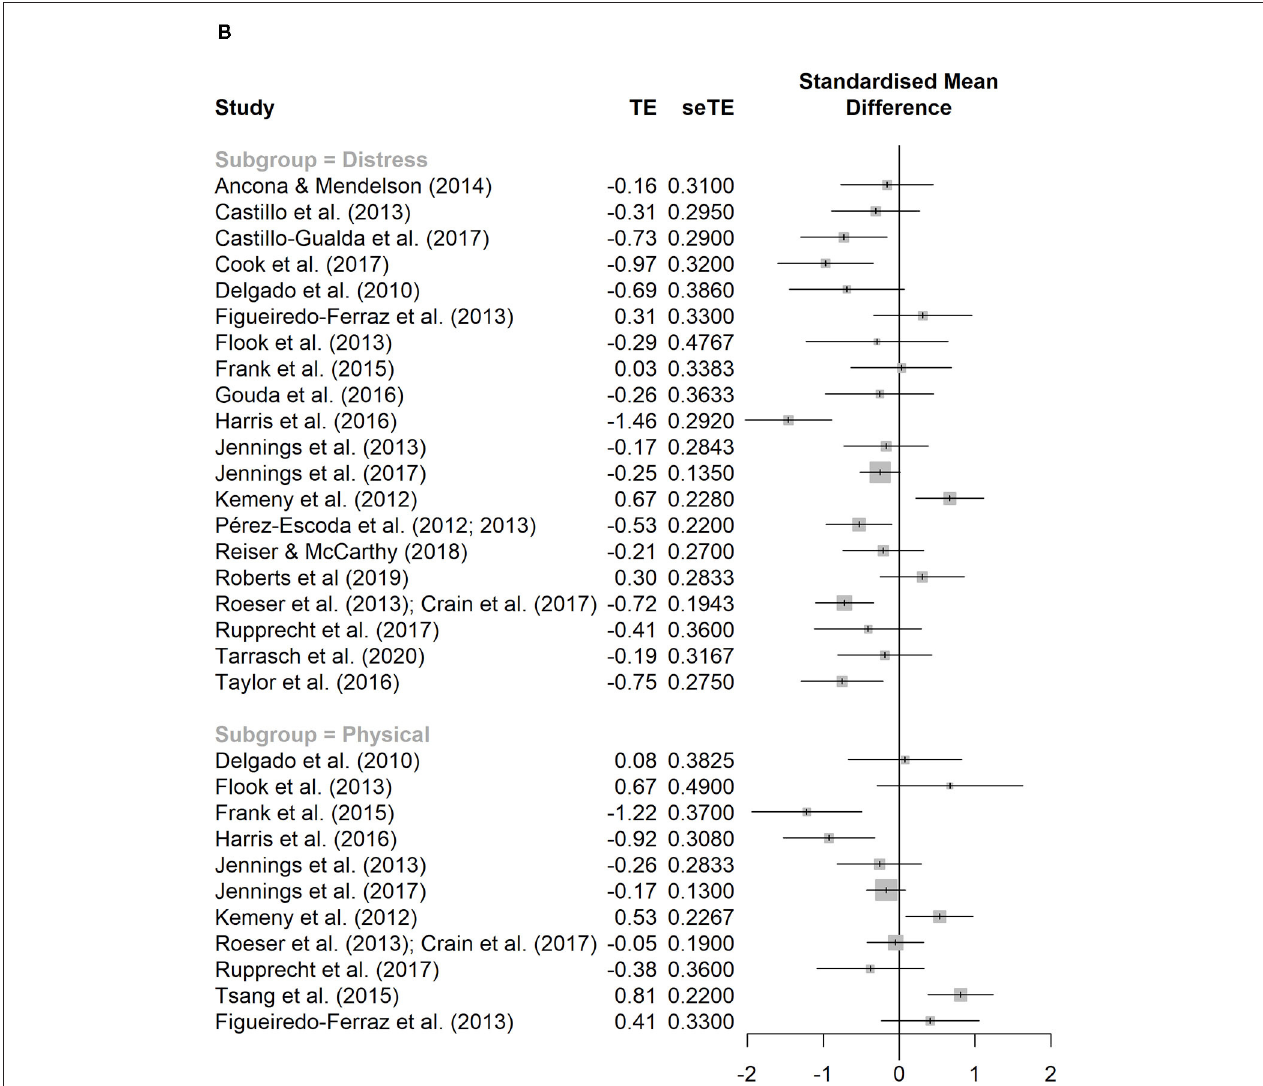
FIGURE 1 | (A) Forest plot with weighted average effects for the SEC, Well-being, and Classroom climate and instructional practices domains by study of interventions only targeting teachers. (B) Forest plot with weighted average effects for the Psychological distress and Physical distress domains by study of interventions only targeting